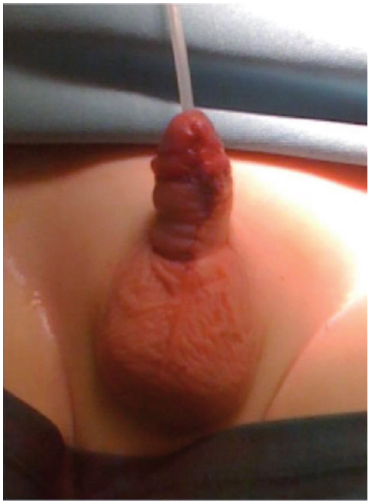
Figure 1: Congenital anterior urethrocutaneous fistula before surgery. Figure 2: The ventral surface of the penis after immediately surgical correction by one-stage transverse preputial onlay island flap